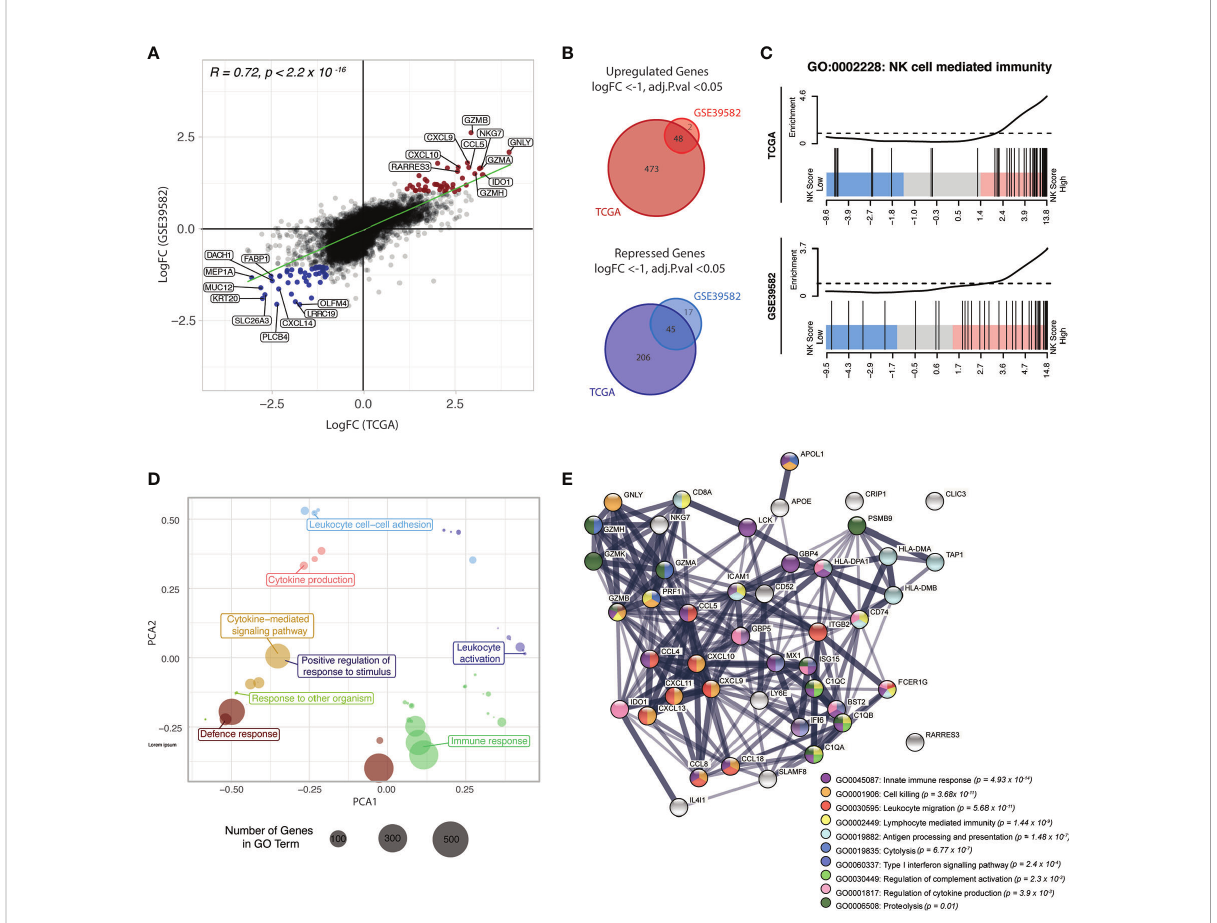
FIGURE 6 NK score is associated with high chemokine and cytolytic activity. (A) Scatterplot of the LogFCs of genes comparing NK-high and NK-low groups in TCGA and GSE39582 datasets; Genes that were differentially upregulated (red points) or repressed (blue points) in both datasets are highlighted. DEGs were de fi ned as those with adjusted p-value < 0.05 and absolute LogFC > 1 or LogFC < -1. (B) Venn diagram of upregulated ( upper ) and down- regulated ( lower ) DEGs identi fi ed in (A). (C) Barcode plots showing enrichment of genes in the “ NK cell mediated immunity ” gene set (GO:0002228) in NK-high samples in both data sets (D) PCA plot of top 50 most signi fi cant GO terms in the NK-high group, distributed by semantic similarity of genes within each term (E) STRING network analysis of protein-protein interactions between the overlapping upregulated DEGs from (A), coloured by biological process. Thickness of the connecting line indicates the strength of evidence for the predicted interaction. GO, gene ontology